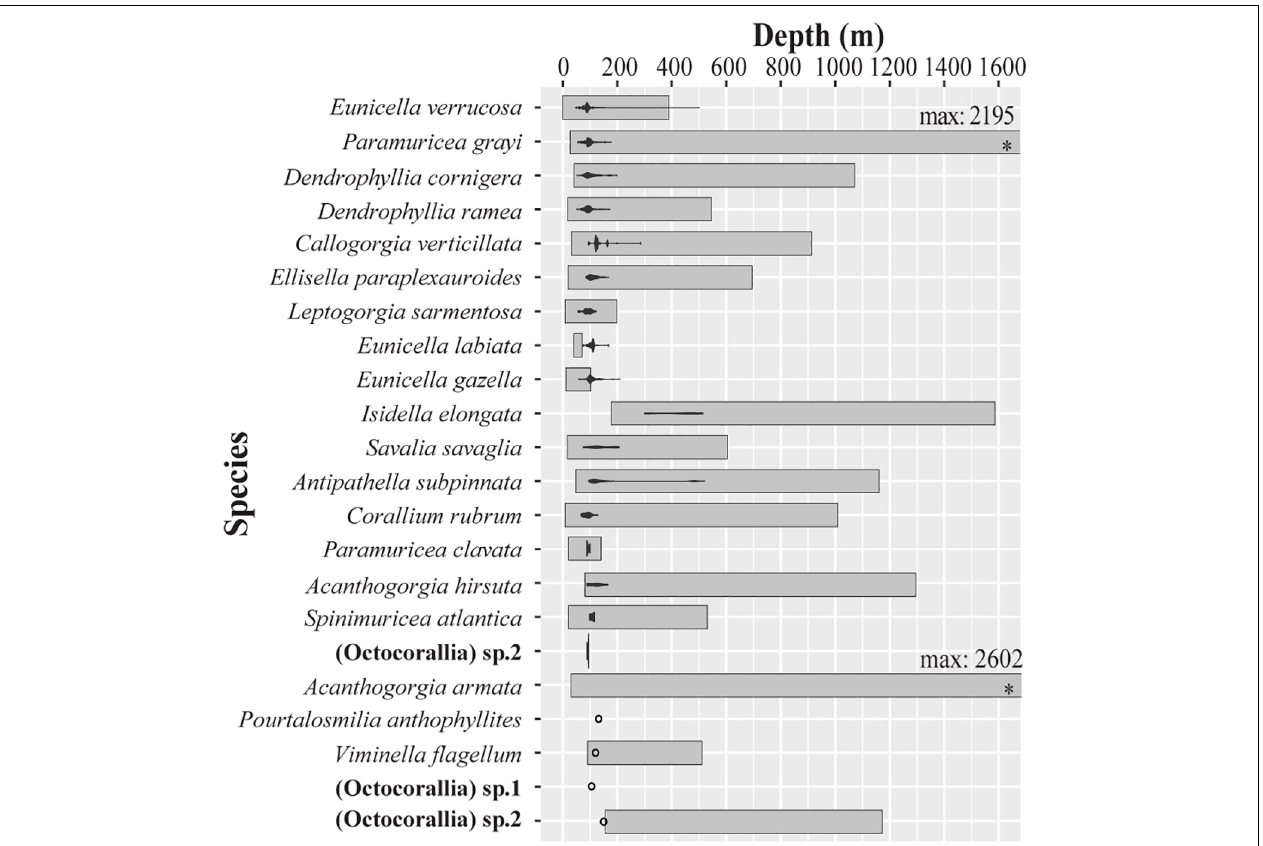
FIGURE 3 | Collection depth ranges of the coral species caught as coral bycatch by bottom-set gillnets in Sages (southern Portugal) during the two seasons studied. The bathymetric distribution recorded in the literature for each species is shown as gray band. The abundance of each species at each depth is also shown with a violin